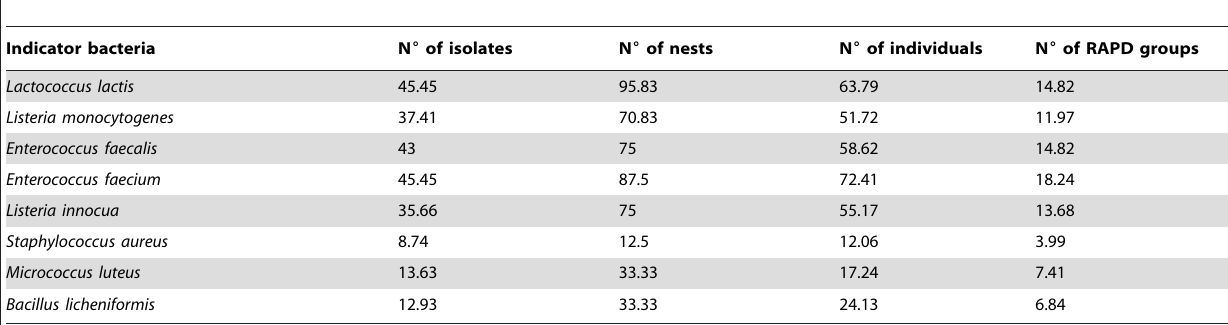
Table 1. Inhibition rates (%) for: isolated strains, nests, individuals and RAPD groups against each indicator bacteria.